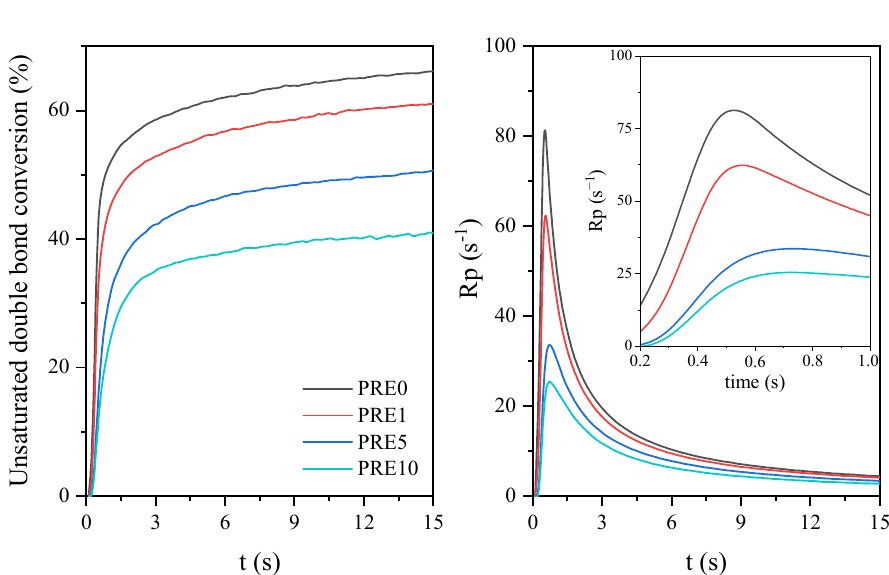
Figure 3. The unsaturated double bond conversion and photopolymerization rate (Rp) curves of selected urethane acrylate modifications with different amounts of eugenol.